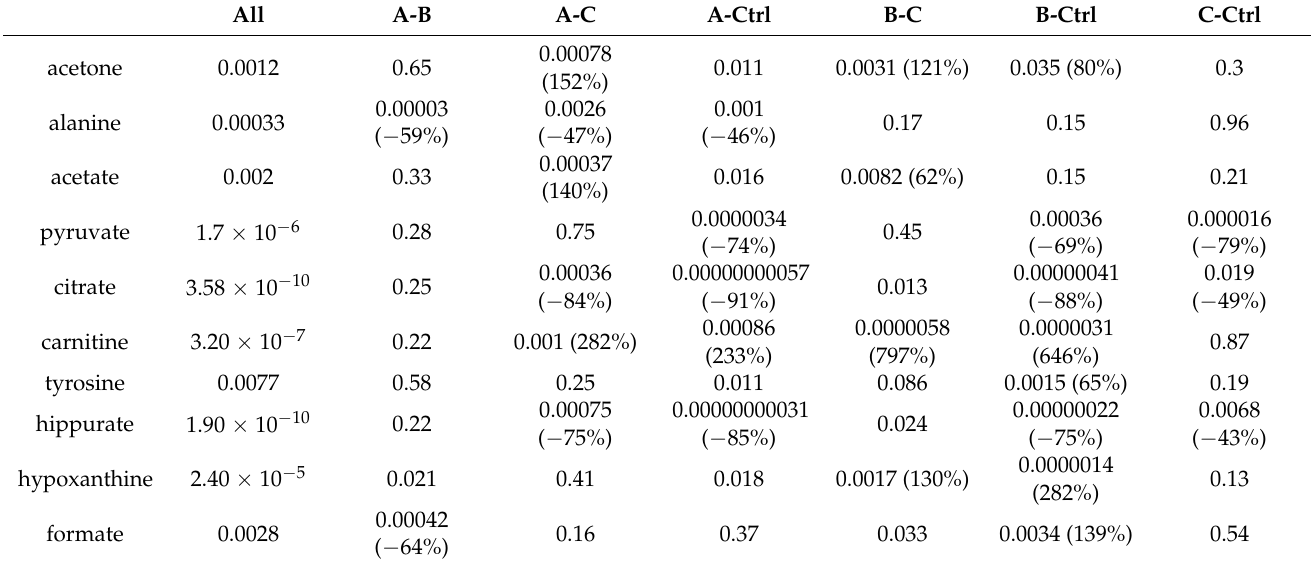
Table 4. The p -values from the statistical comparison of relative levels of urine metabolites (related to the abundance of urine creatinine) in patients on the first day of hospitalization (A), one week (B), and one month later (C) and controls (ctrl). For significant changes ( p -value <0.0083 after Bonferroni correction), a percental difference was calculated using the